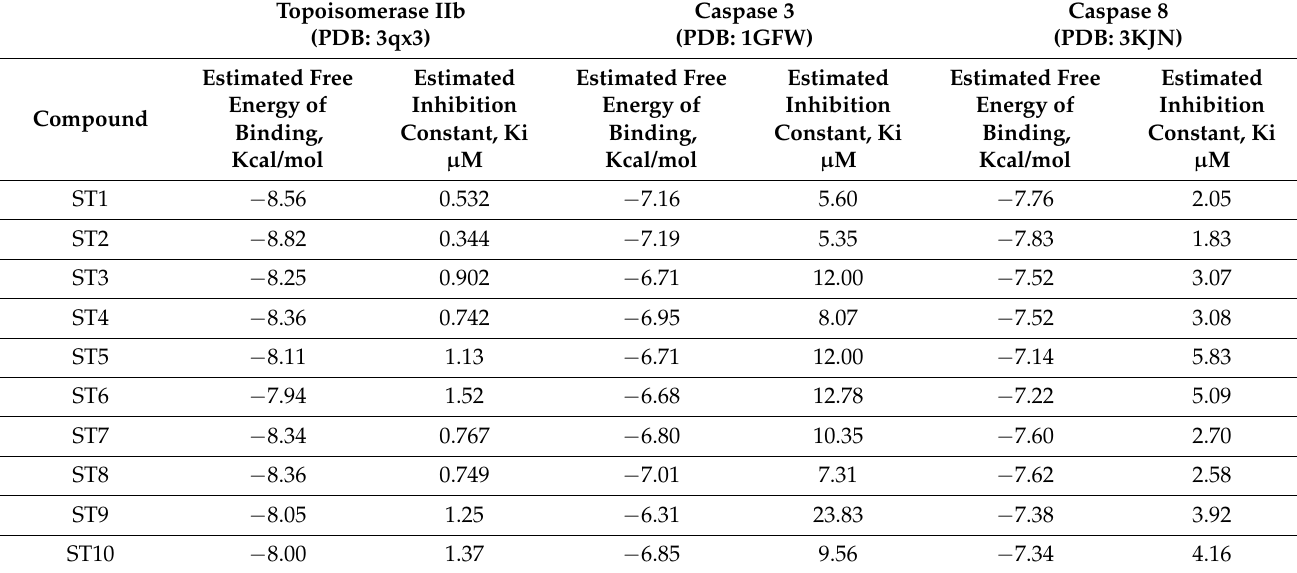
Table 1. Docking simulations for activities of the ST1 – ST15 to Topoisomerase IIb (PDB: 3qx3), Caspase 3 (PDB: 1GFW), and Caspase 8 (PDB: